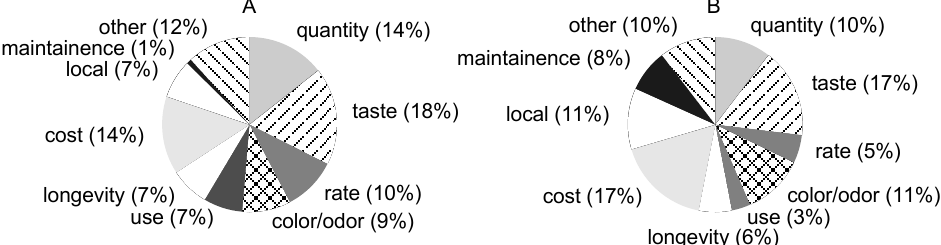
Figure 10. The most important characteristics of a water treatment technology as reported by 100 households in communities A and B (South Africa). Researchers asked subjects, “What are the three most important water treatment characteristics, in no particular order, to you and your family?” in the vernacular. The most important characteristic identified was taste of the treated water, although it was not statistically more important than price of the water treatment technology. The “other” category includes ease of use of the technology, ease of maintenance, and any other unlisted factors.